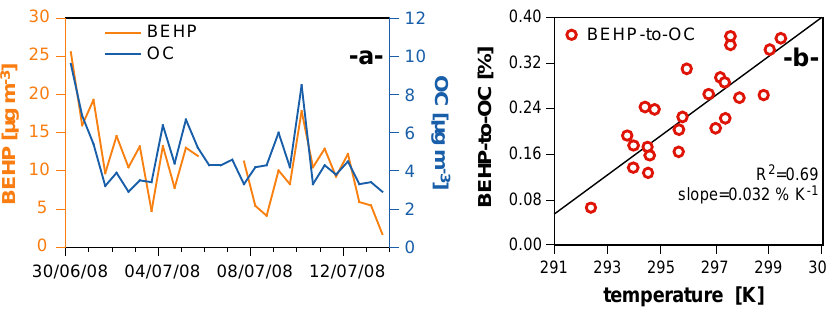
Fig. 11 Fig. 11. BEHP (Bis(2-ethylhexyl) phthalate; plasticizer mostly in the particulate phase) trends during the period of study: (a) time series of BEHP and OC; good correlation between the two components is observed ( R 2 = 0 . 73). (b) Scatter plot of BEHP contribution to the organic carbon (%) versus temperature (K). The contribution of BEHP increases with temperature which underscore that its emission proceeds via evaporation from the polymeric matrix.